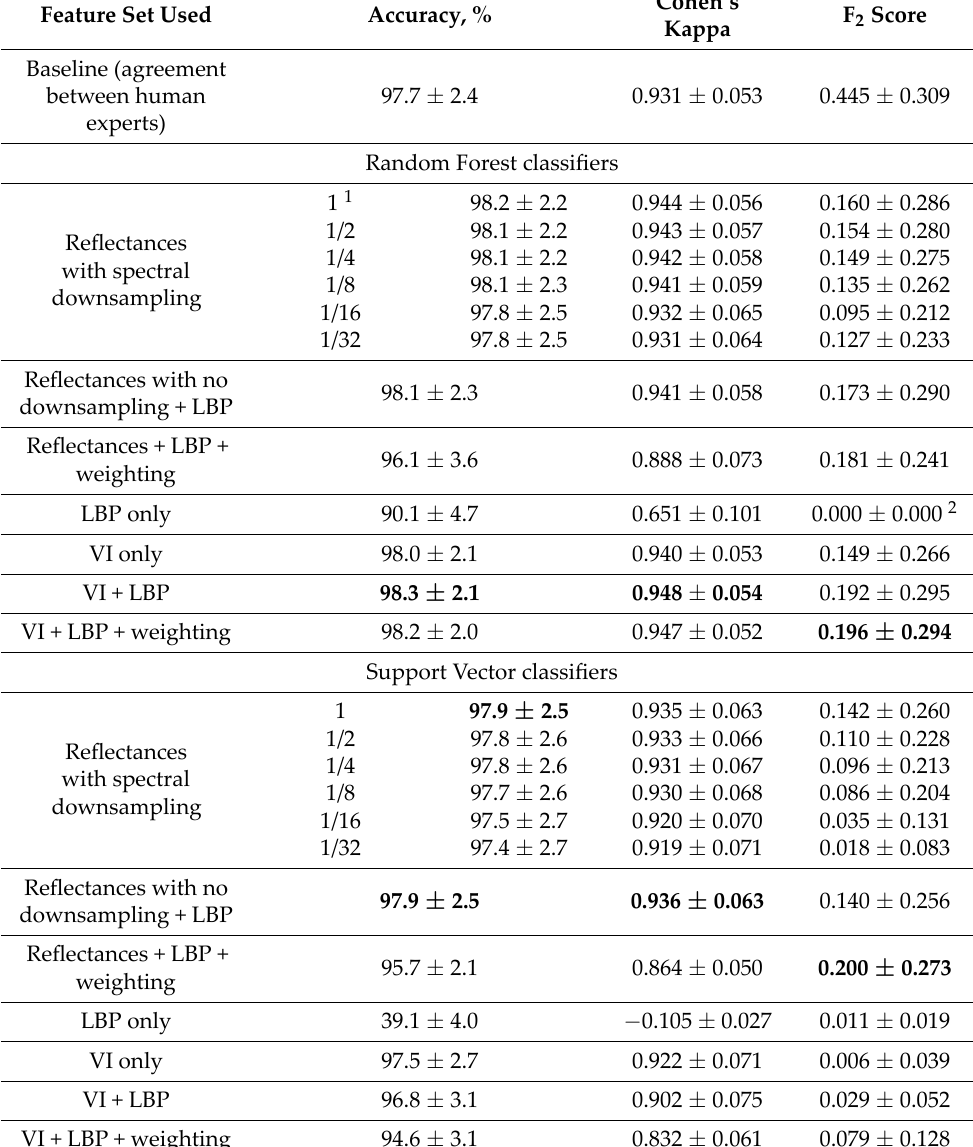
Table 2. Per‑pixel classification